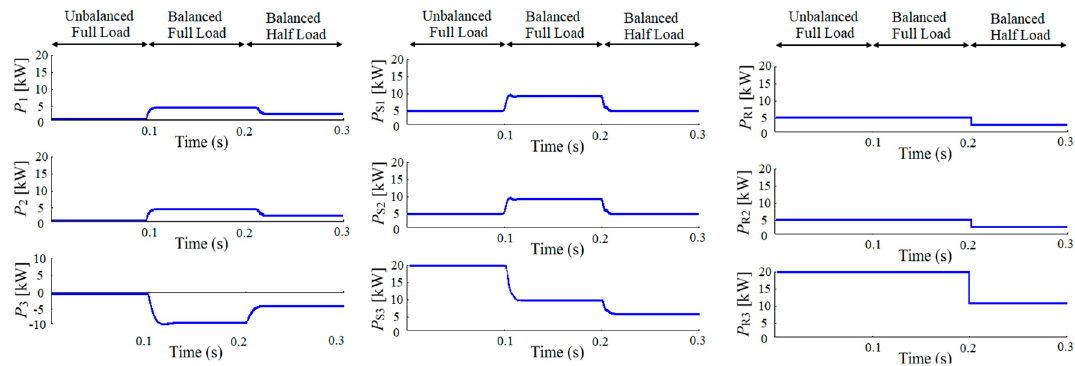
Figure 8. Simulation results for the proposed power distribution system with the TAB converter and power flow control.